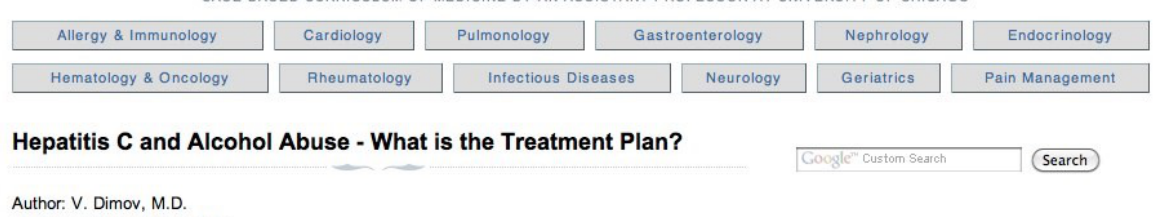
Figure 1. A sample rounding blogging